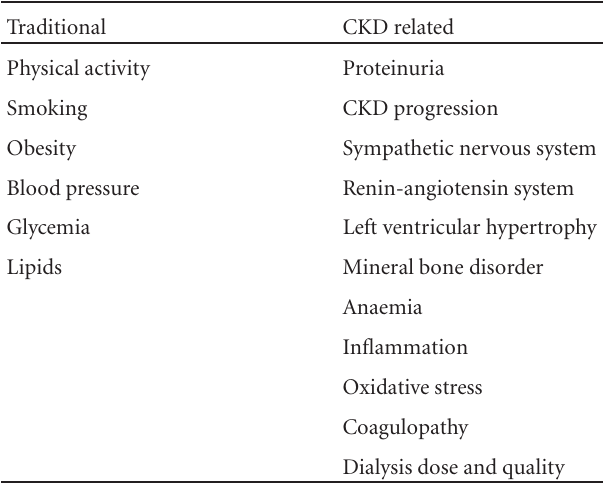
Table 1: Targets for cardiovascular risk modification in